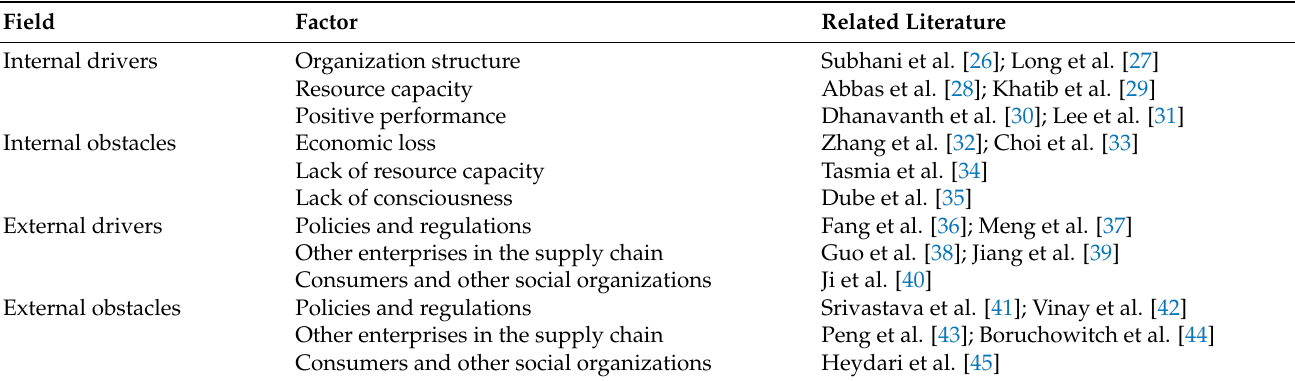
Table 1. Relevant research on driving and hindering factors for enterprises to implement green supply-chain